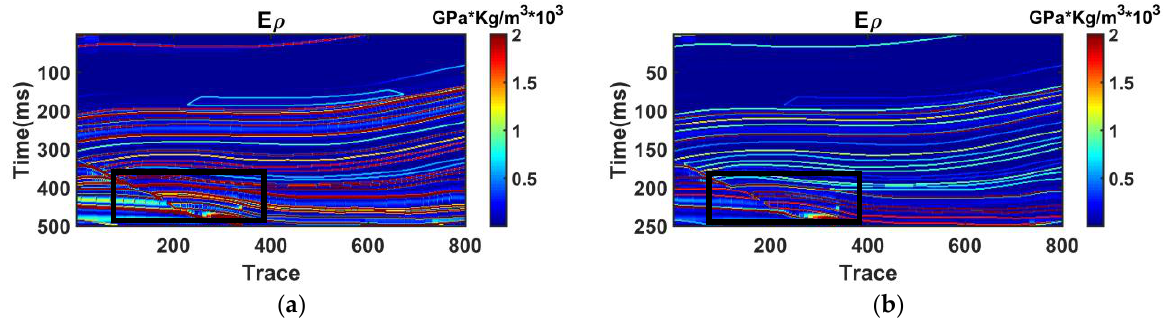
Figure 7. E ρ absolute error of inversion based on ( a ) traditional method and ( b ) reweighted Lp method.